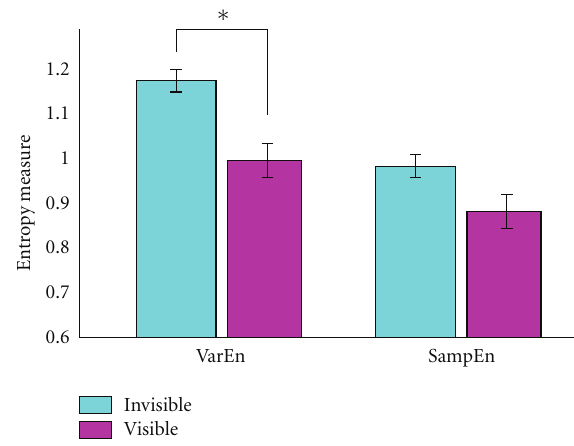
Figure 2: Comparison of the proposed variance entropy (VarEn) and sample entropy (SampEn) in discriminating the di ff erent perceptual conditions (Invisible versus Visible). Shown are the means and the standard errors of means of VarEn (left) and SampEn (right). As a result, the VarEn exhibits significant di ff erence between two perceptual conditions ( p = 7 . 69 e − 4, indicated by the sign “ ∗ (cid:4)(cid:4) ), but the SampEn does not ( P = 0 .